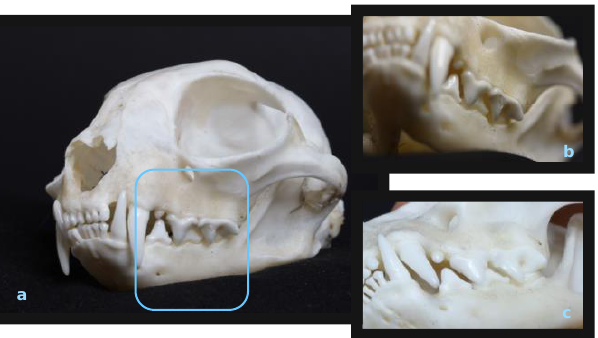
Figure 5. Cat skull and teeth: semi profile view ( a ), lack of adhesion of the side teeth — scissor arrangement ( b , c ) (by Małgorzata Peruga) .